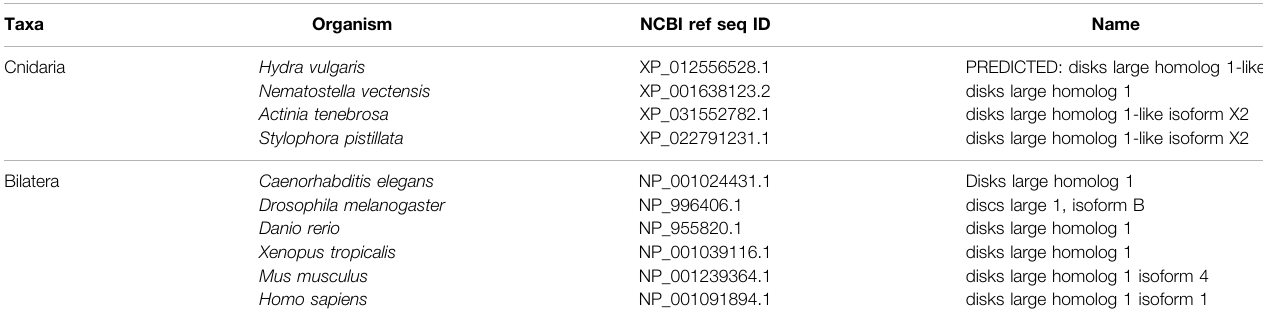
TABLE 7 | Discs Large (Dlg).